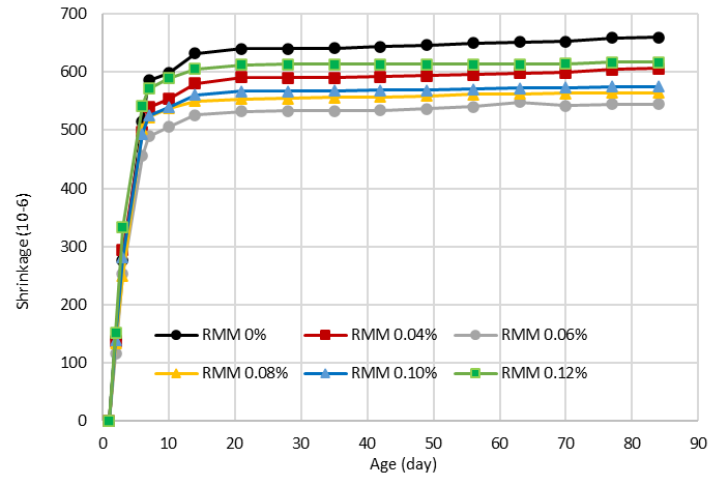
Figure 4. The shrinkage development with